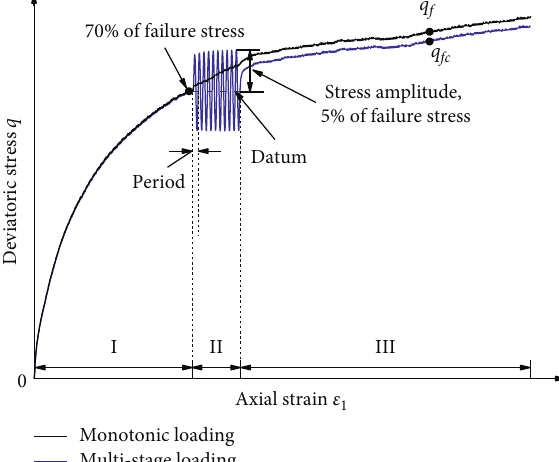
Figure 5: Idealized static and cyclic loading curves of sliding zone soil.